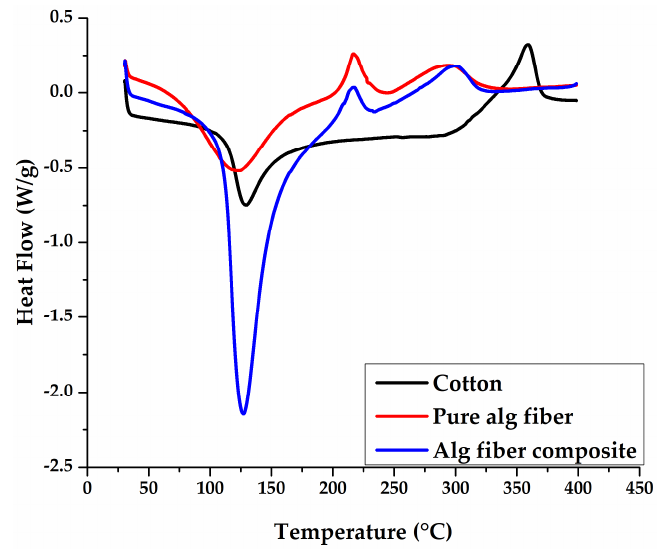
Figure 6. DSC thermograms of cotton, pure Hydrogel alginate fiber, and cotton reinforced alginate hydrogel fiber.